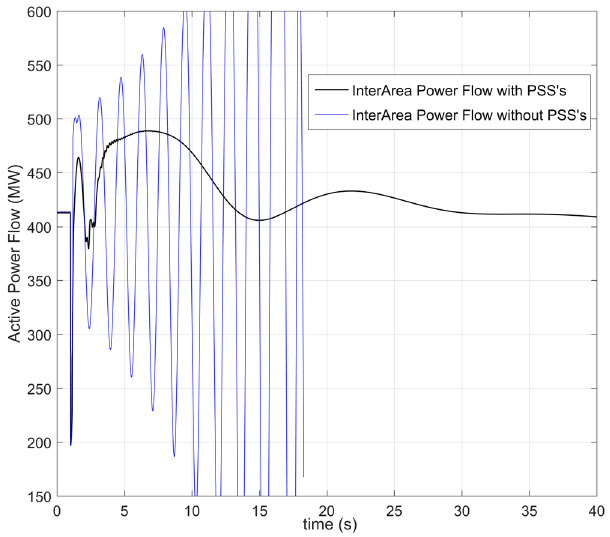
Figure 8. Inter-area oscillations in power flow after three-phase